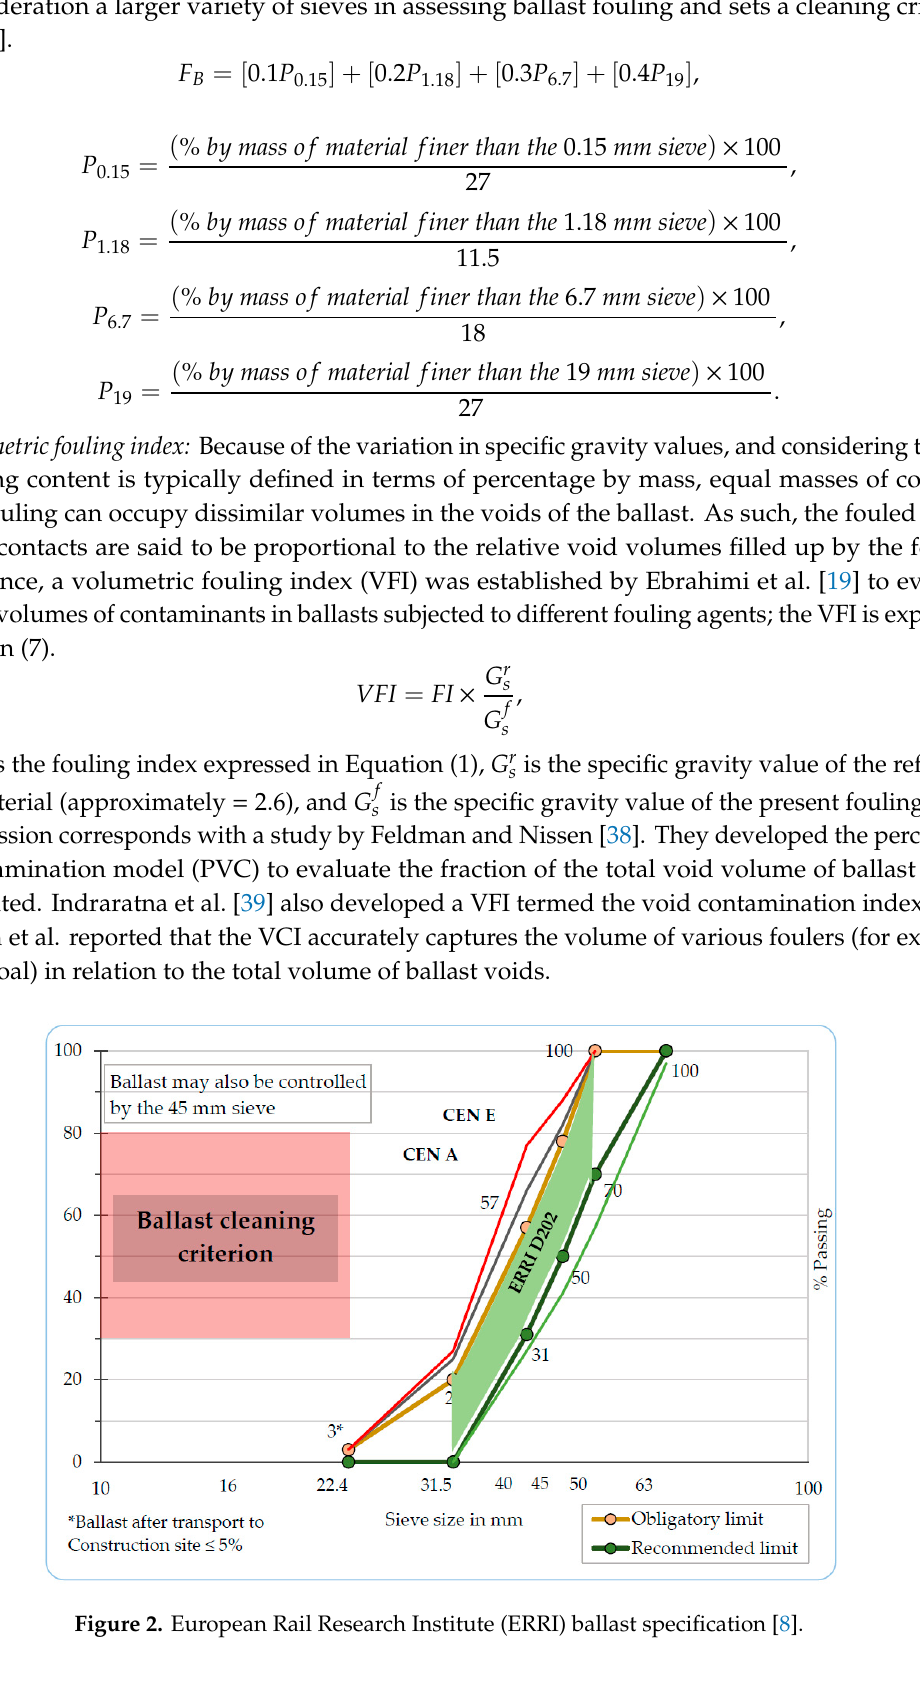
( c ) Figure 3. Ballast fouling stages: ( a ) clean ballast contact point; ( b ) minor fouling, contact point unaffected; ( c ) contact point contaminated, causing instability [19].